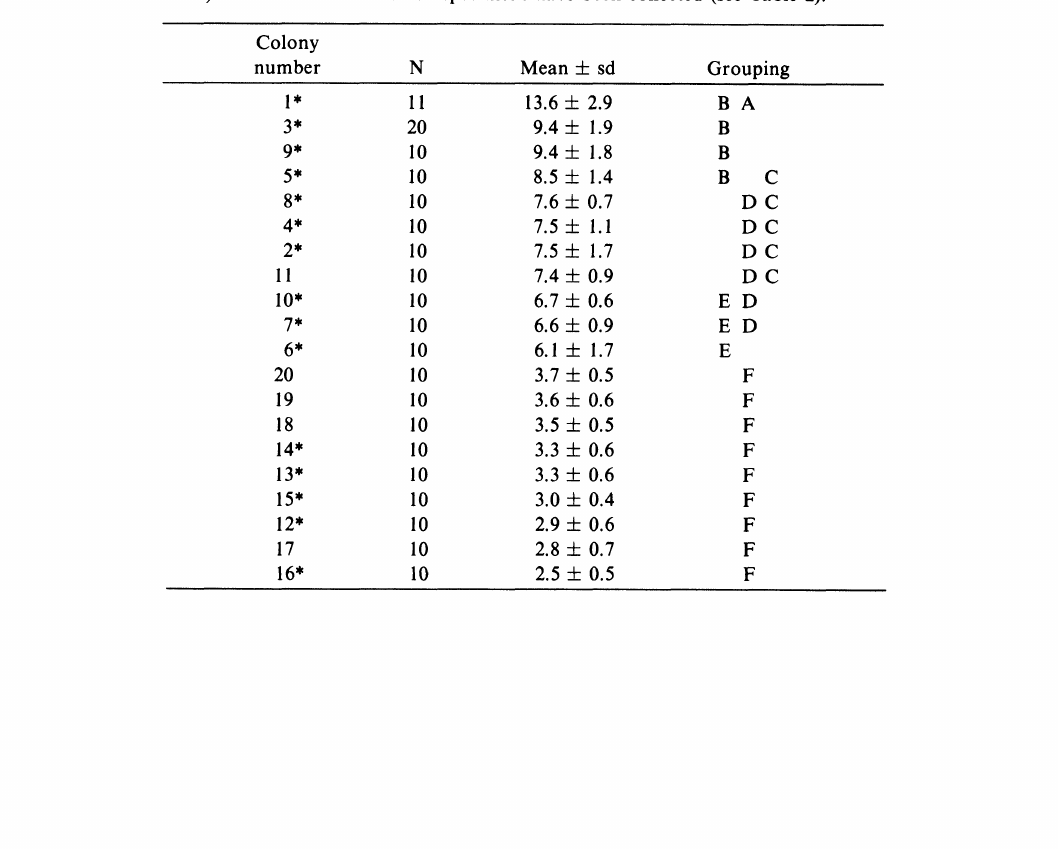
Table 3. Duncan’s multiple range test for variable P/C (pulse number per chirp). Means with the same letter and overlapping ranges of means designated by two or more letters are not significantly different. The range of means designated F are significantly different from overlapping range of means designated A, B, C, D and E (p < .05). *- colonies from which specimens have been collected (see Table